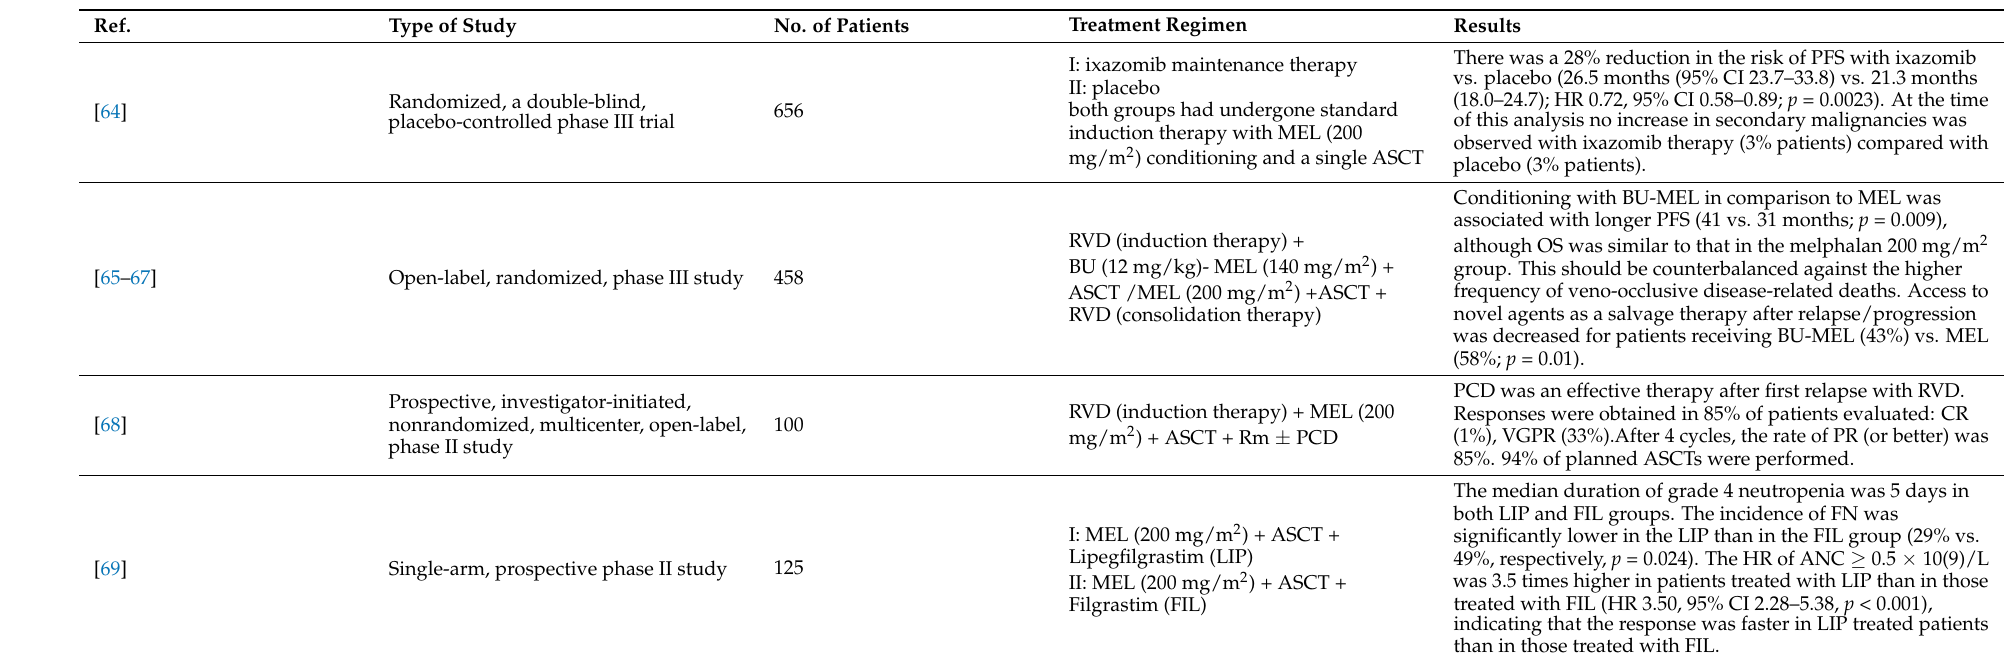
Table 2. Clinical trials assessing the efficacy of combination therapy for the treatment of MM, including melphalan-new directions. Published clinical studies featuring new MM treatment regimens with Autologous Stem Cell